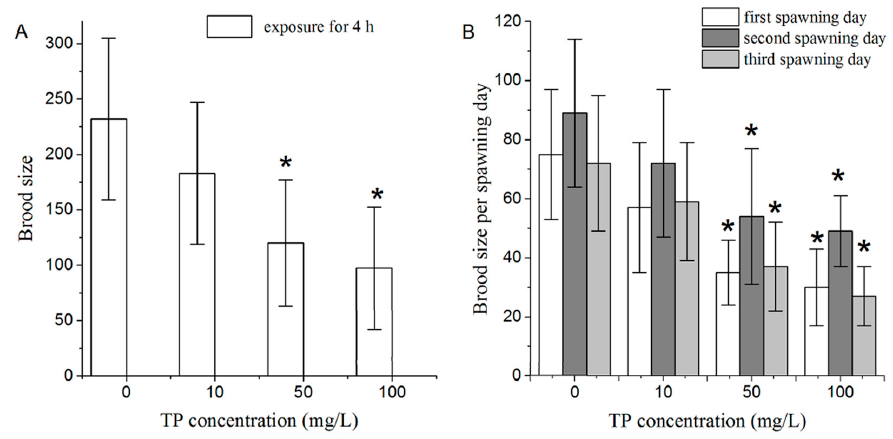
Figure 3. Effects of exposure to TP on the fertility of nematodes: ( A ) effects of 4 h TP exposure on brood size; and ( B ) effects of 4 h TP exposure on brood size in each spawning day. TP, Triptolide. Bars represent means ± SEM. * p < 0.05 vs. the control group.